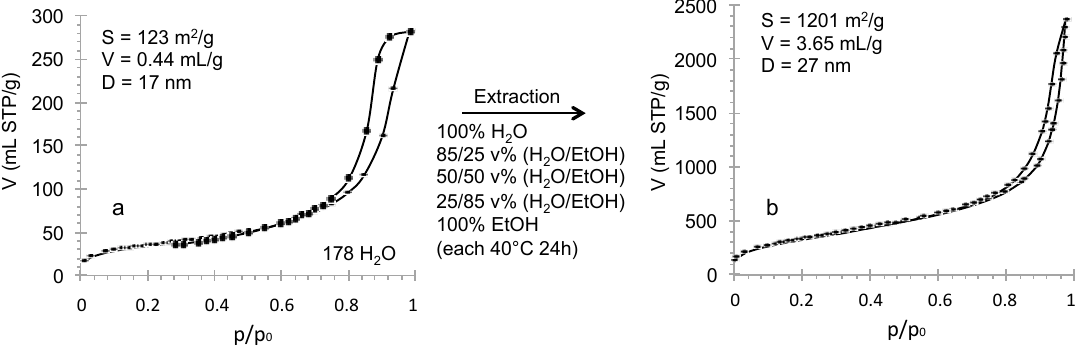
Figure 13. Nitrogen sorption isotherms at 77 K of as-synthesized ( a ) and solvent-extracted ( b ) mesoporous silica monoliths (aerogels-like materials) prepared with 178 H 2 O and high amount of surfactant-polymer DM-970.